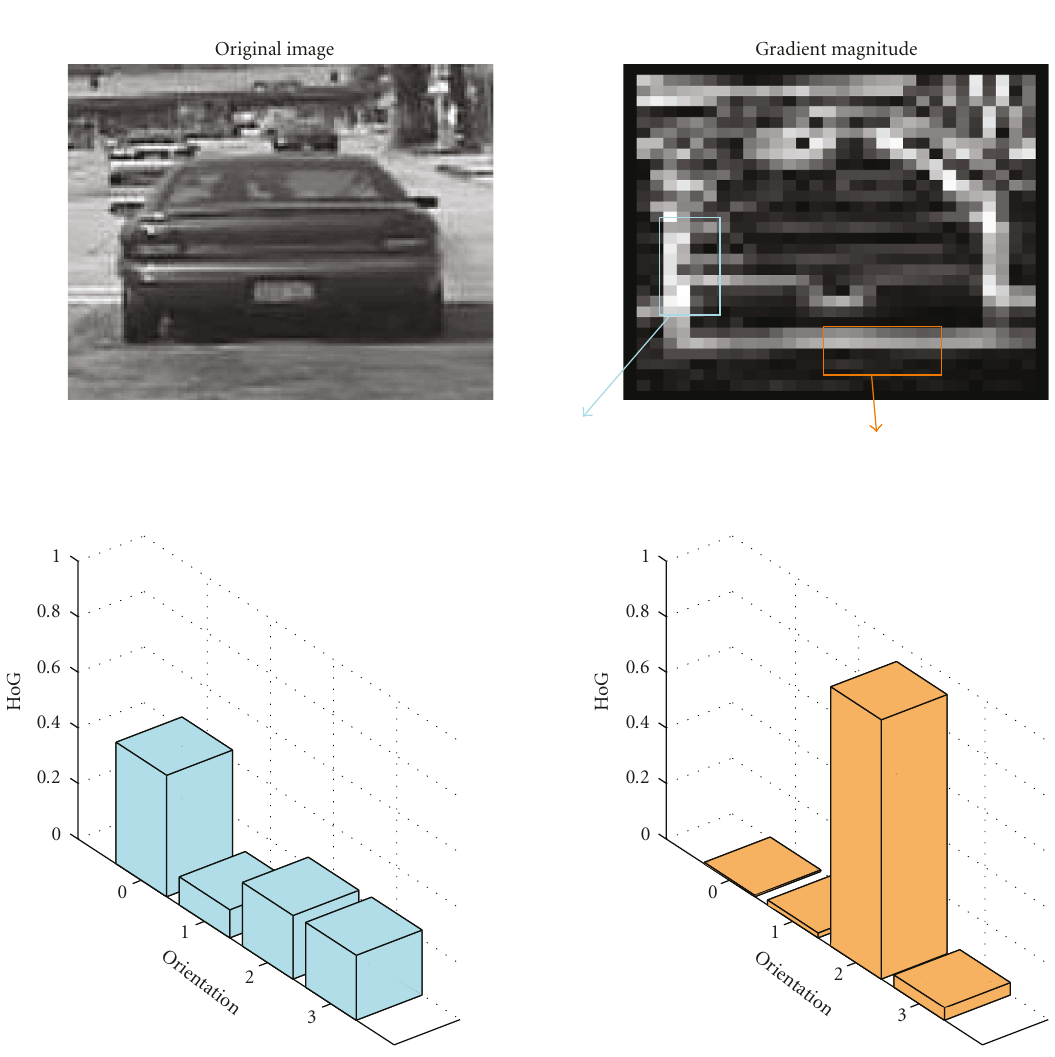
Figure 4: Result of application of HoG on a vehicle